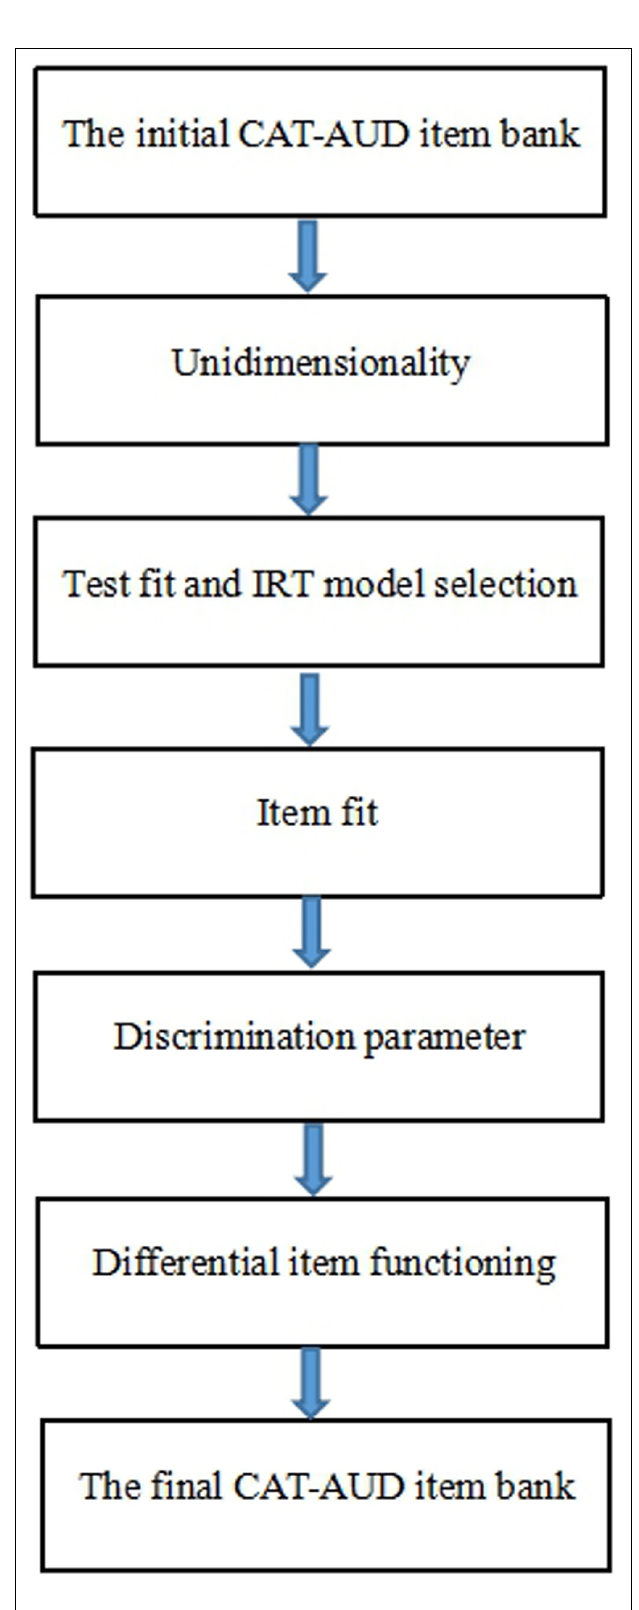
FIGURE 1 | The steps of the psychometric measurement requirements of IRT used for the item bank